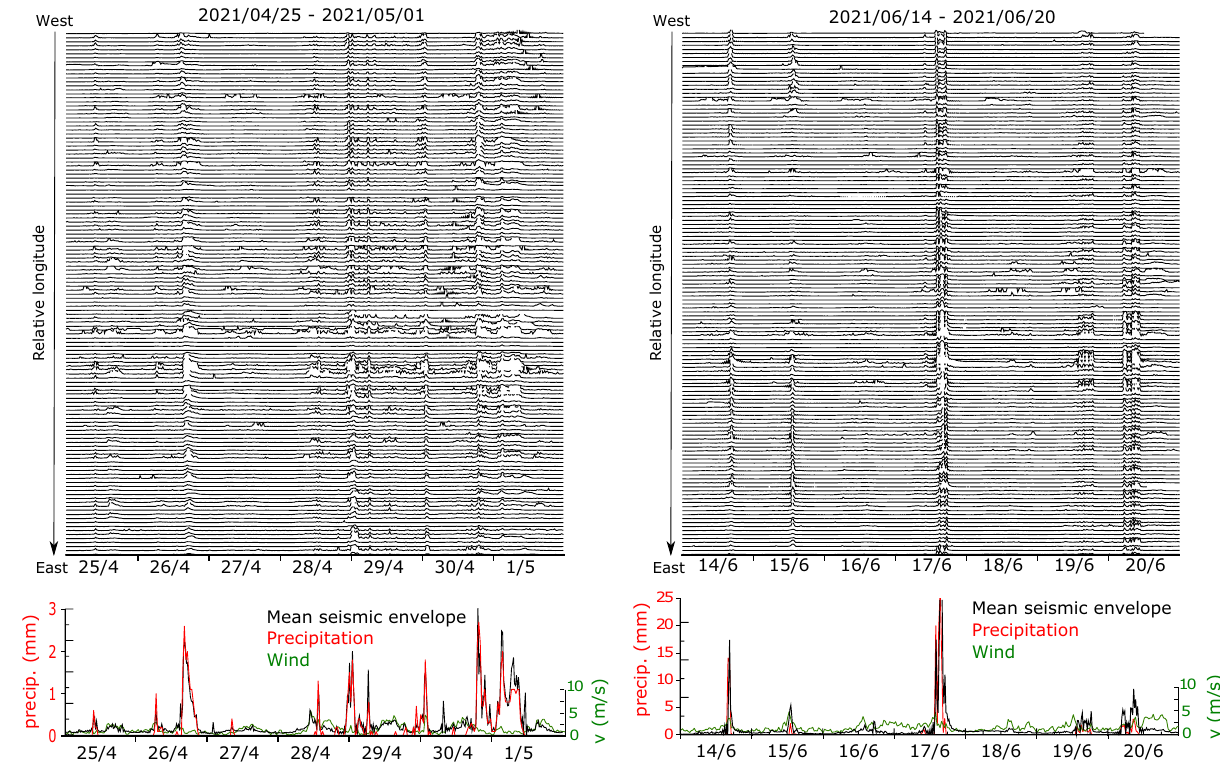
Figure 3. Top panels: Envelopes of the seismic signals during the late April (left) and mid-June rainfall episodes (right), downsampled to one sample every 20 min. Traces are ordered following longitude, with westward sites on top. All traces are displayed using the same amplitude scale, expressed in digital counts. Lower panels: precipitation (red line) and wind speed (green line) at Puigcerdà and the mean seismic envelope calculated using the five sites closer to the meteorological station (black line). Vertical scales have been adjusted to highlight the correlation between seismic and meteorological